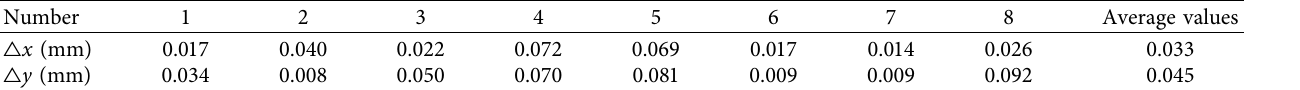
Table 6: Experimental data of the eye-in-hand monocular vision system positioning error.